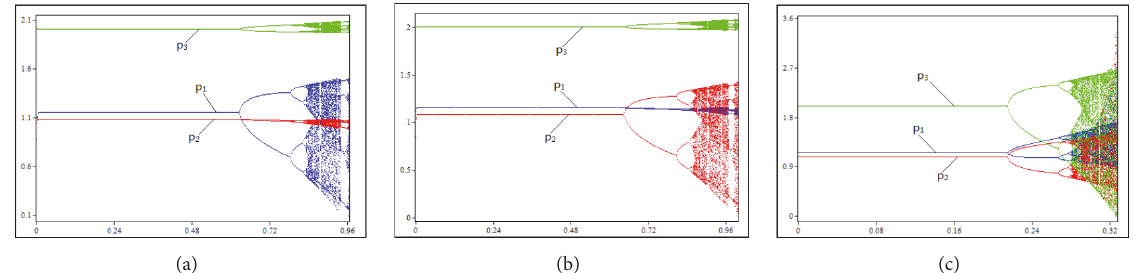
Figure 6: (a) Bifurcations of 𝑝 𝑖 as 𝛼 goes when 𝛽 = 0.25 and 𝛾 = 0.15 , (b) bifurcations of 𝑝 𝑖 as 𝛽 goes when 𝛼 = 0.16 and 𝛾 = 0.15 , and (c) bifurcations of 𝑝 𝑖 as 𝛾 goes when 𝛼 = 0.16 and 𝛽 = 0.25 .